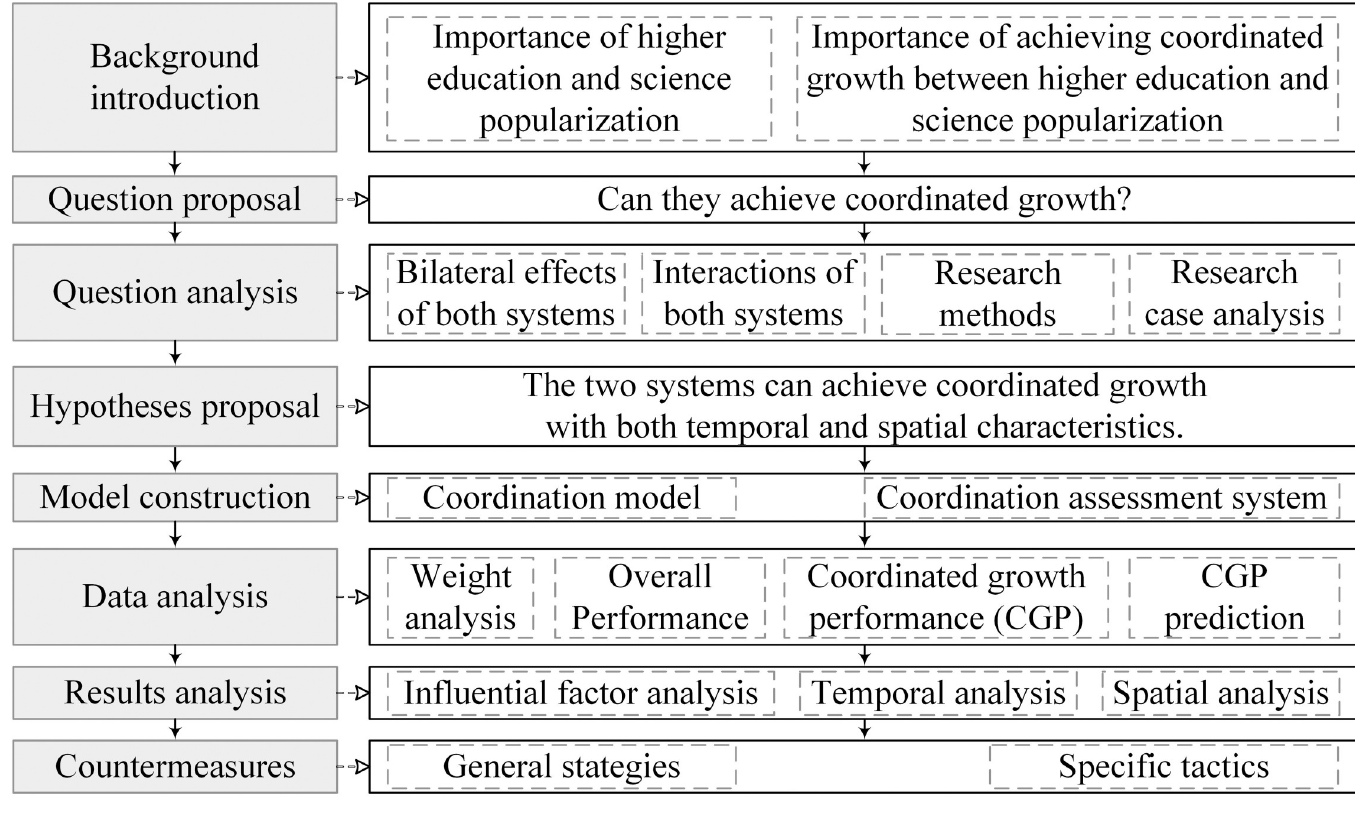
Fig 2. Flowchart of the research